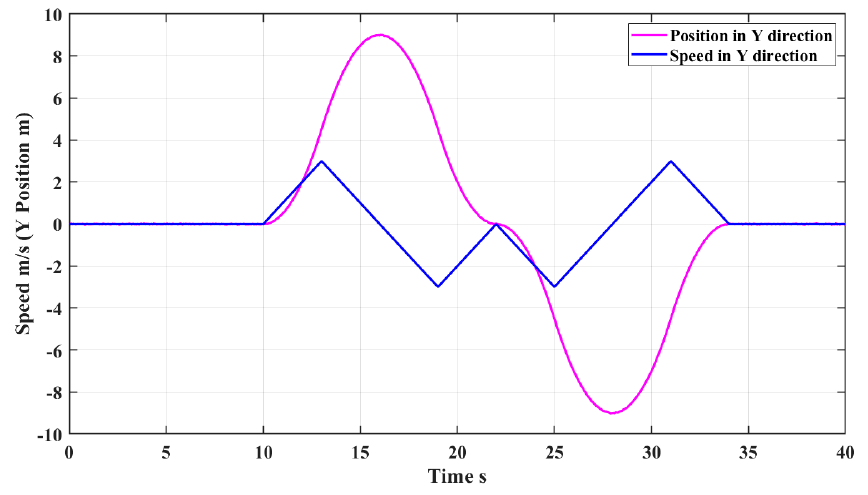
Figure 5. Desired path two for track-following servo control is plotted in this figure. The initial position of the CLRV is ( − 40, 0).